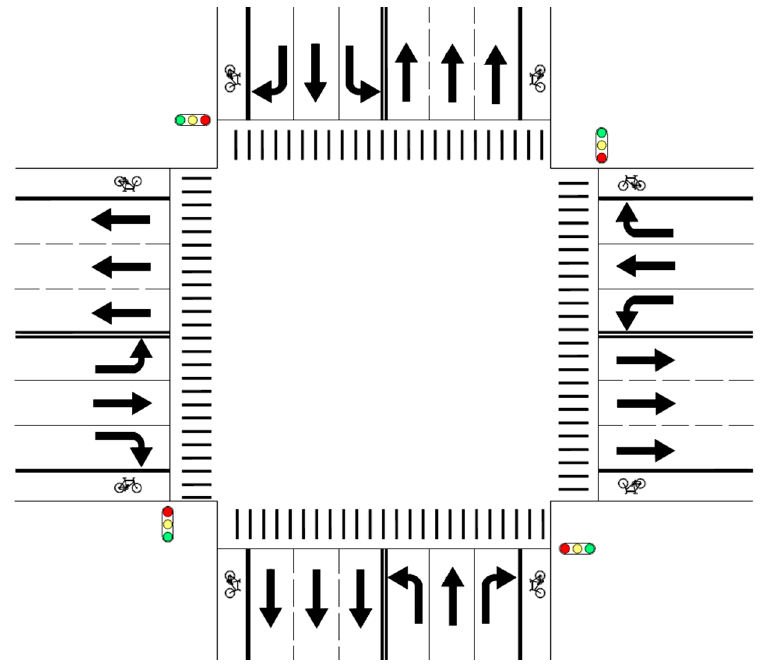
Figure 1. Intersection scheme with exclusive lanes for motorized vehicles and exclusive lanes for non-motorized vehicles.